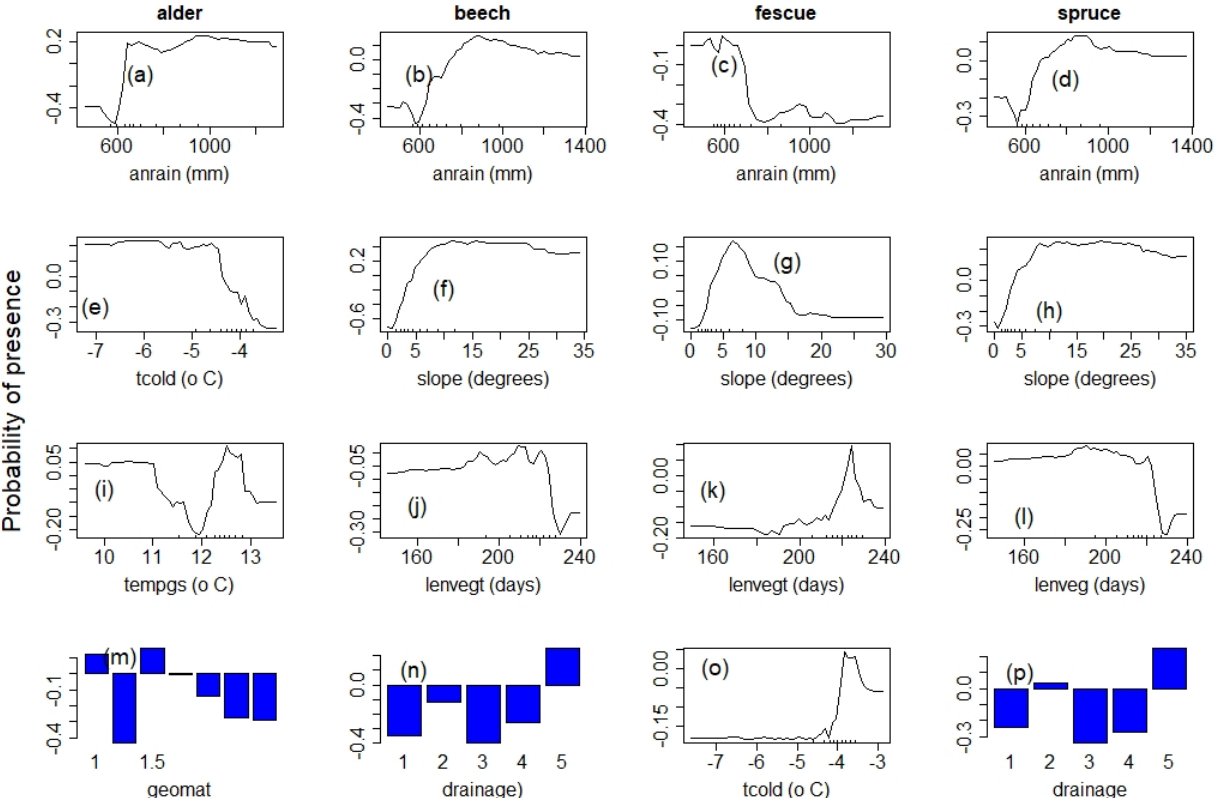
Figure 5. Species response to climate and environmental gradient: panel 1: alder; panel 2: beech; panel 3: fescue; panel 4: spruce; “anrain” = annual rainfall; “tcold” = average minimum temperature; “tempgs” = temperature of the growing season; “lenvgt” = length of the vegetation period and “geomat” = geological material. ( a – d ) annual rainfall, ( e , o ) average minimum temperature, ( f – h ) variation with slope angle, ( i ) average temperature of the growing season, ( j – l ) length of the vegetation season in days, ( m ) geological material scaled from 0 for very coarse to 1.9 for very fine material, ( n , p ) soil drainage scaled from 1 for poorly drained to 5 for well-drained soils